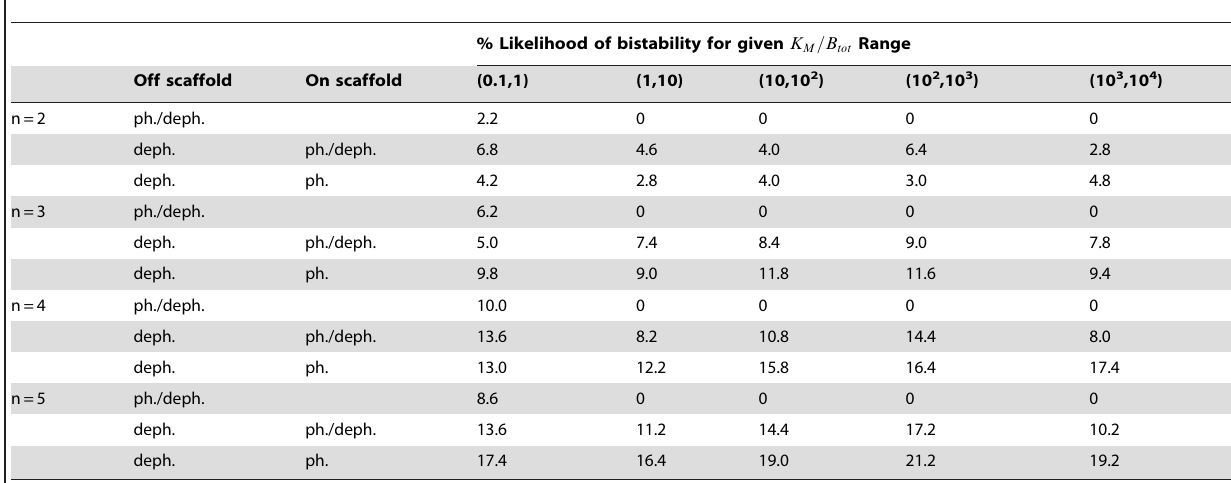
Table 2. Percentage of bistable parameter sets (MA), for increasing K M = B tot values.